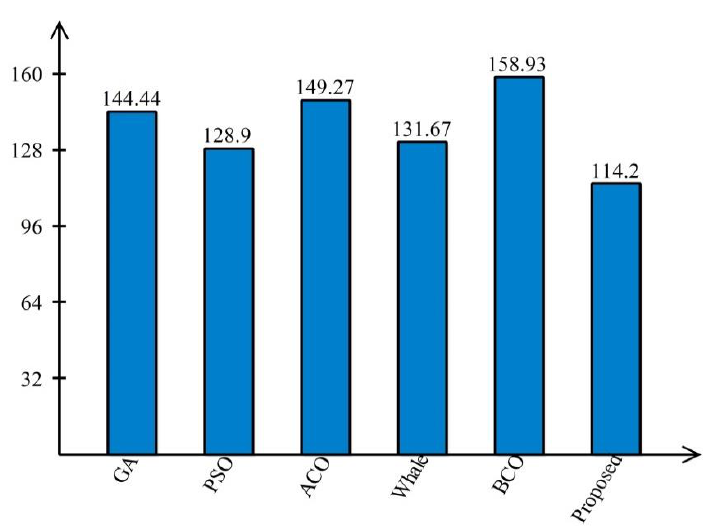
Figure 16. Time comparison on the CASIA B dataset .